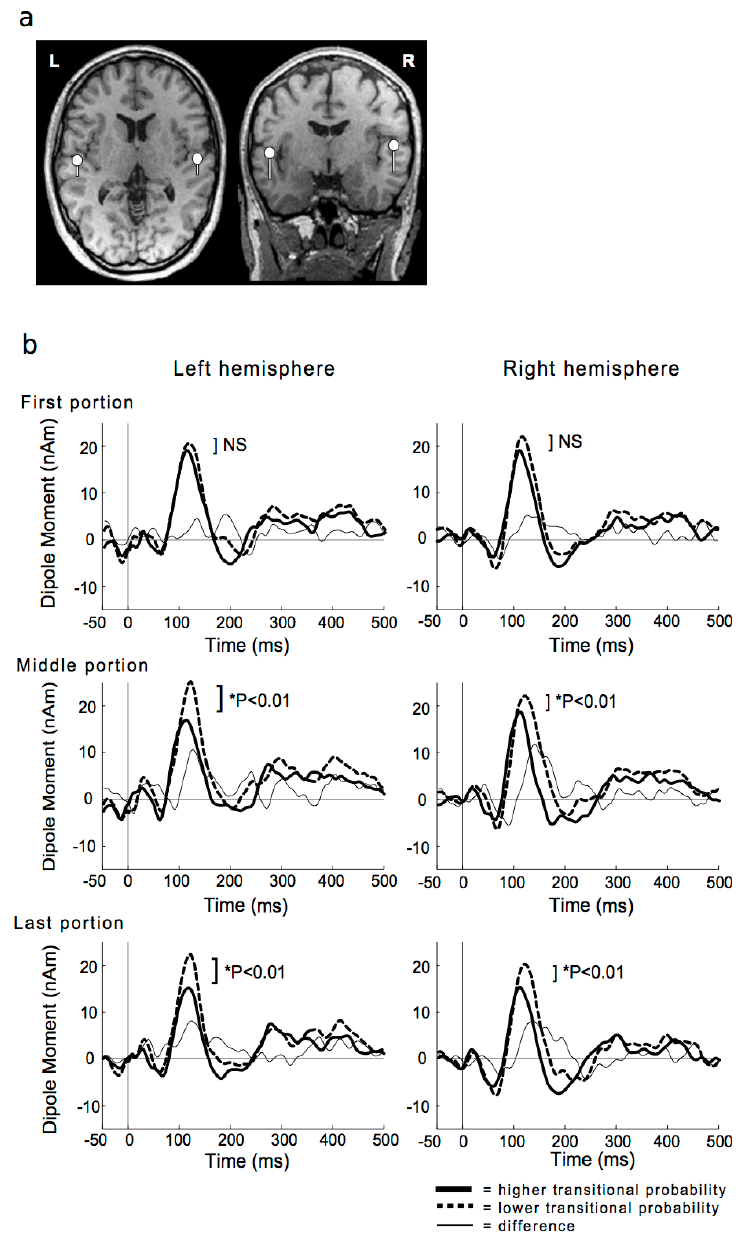
Figure 4. Representative equivalent current dipole (ECD) locations (dots) and orientations (bars) for the N100 m responses superimposed on the magnetic resonance images ( a ) (Daikoku et al., 2014 [32]; and the SL effects ( b ) (Daikoku et al., 2015 [10]) (NS = not significant). When the brain encodes the TP in a sequence, it expects a probable future stimulus with a high TP and inhibits the neural response to predictable stimuli. In the end, the SL effects manifest as a difference in amplitudes of neural responses to stimuli with lower and higher TPs ( b ).